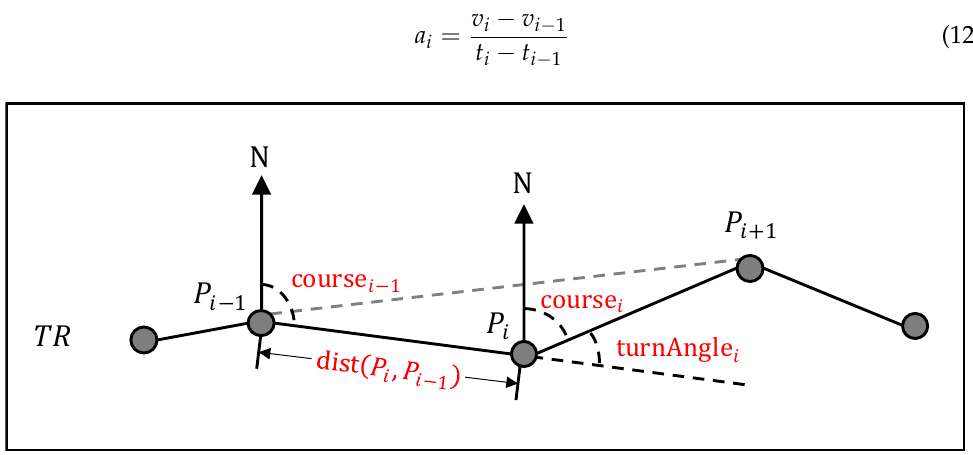
Figure 4. A diagram of trajectory segment.